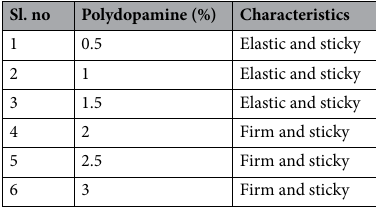
Table 1. Physical nature of GbH.